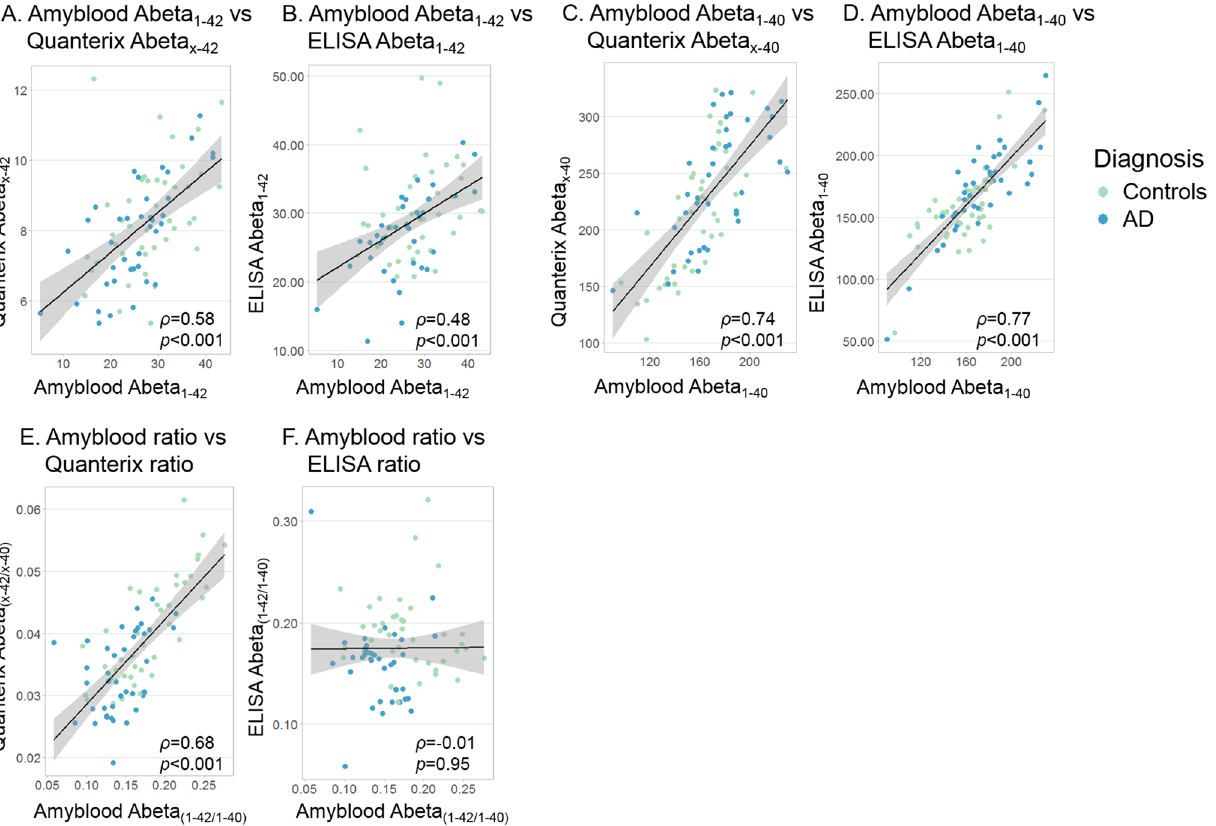
Figure 5. Correlations between Abeta 42, Abeta 40, and the ratio measured with Amyblood, Quanterix and ELISA. ( A, B ) Abeta 42 concentrations measured with Amyblood were correlated with Quanterix and ELISA. ( C, D ) Abeta 40 concentrations measured with Amyblood were correlated with Quanterix and ELISA. ( E, F ) The plasma Abeta 42/40 ratio measured with the Amyblood and Quanterix assays correlated. The plasma Abeta 42/40 ratio measured with ELISA did not correlate with Amyblood. The Abeta 42/40 outlier in ELISA has been excluded from the figure for visualization, but was included in the calculated correlation coefficient. All correlations coefficients are Spearman’s